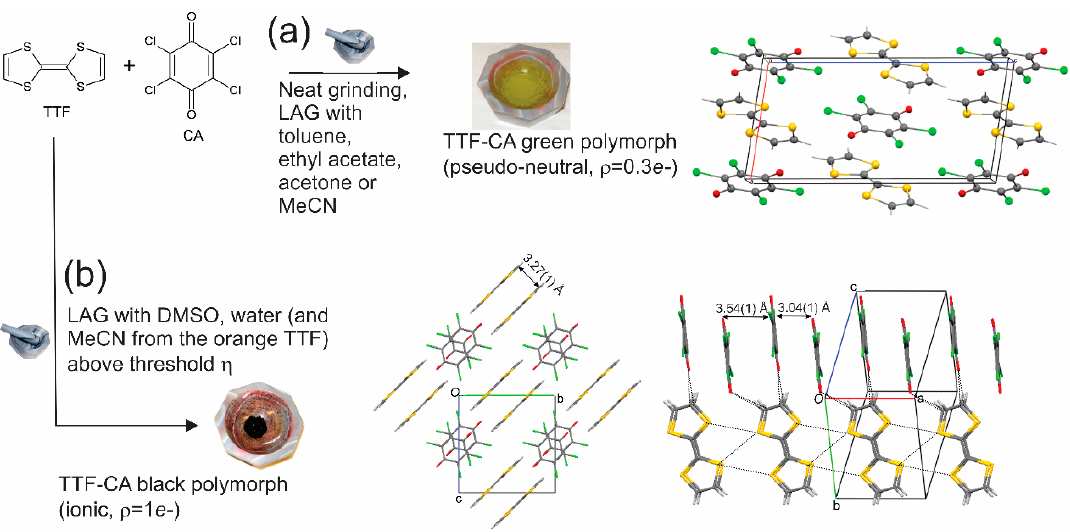
Figure 2. ( a ) Neat grinding and liquid-assisted grinding (LAG) (4 µ L / mg) with low and medium-polarity solvents (toluene, ethyl acetate and acetone), yield the green TTF-CA polymorph. Its room temperature crystal structure (right side) consists of columnar stacks of alternating, equidistant donors and acceptors. The orange TTF (but not the brown) yields the ionic TTF-CA by LAG with MeCN (4 µ L / mg). ( b ) The black (ionic) polymorph is obtained as a single phase by LAG with the highly polar liquids water and DMSO used above threshold η , which are smaller for the orange TTF (2 and 0.02 µ L / mg respectively) than for the brown TTF (4 µ L / mg for both liquids) [18]. The crystal structure of the ionic form containing columns of dicationic dimers (TTF + • ) 2 and selected intermolecular distances are shown at the center and right. C = gray, Cl = green, O = red, S = yellow and H = light gray.